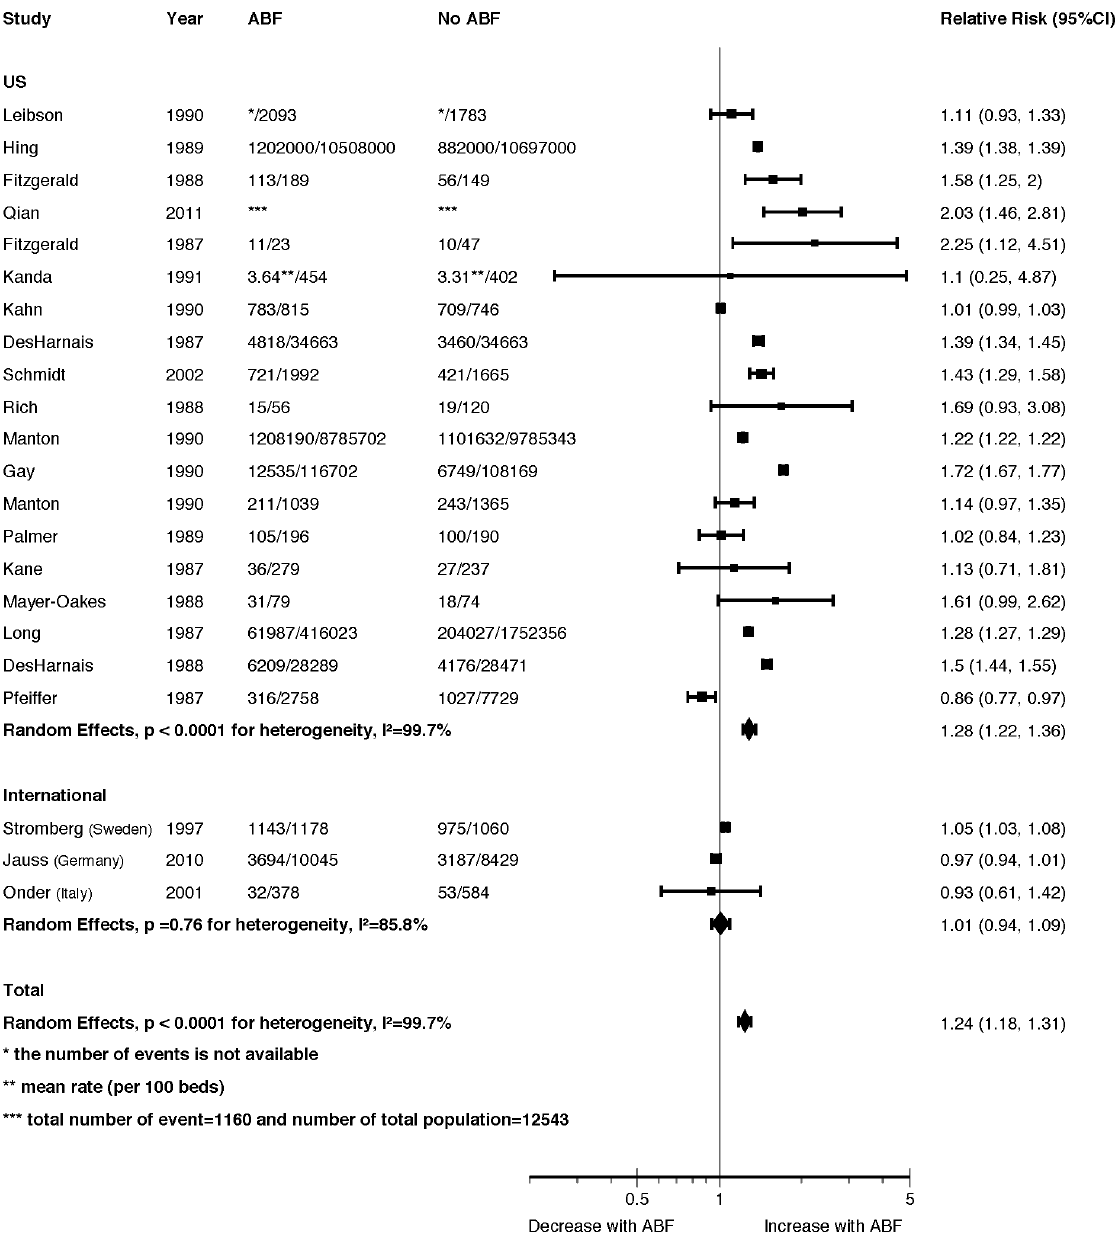
Figure 4. Discharge Destination Forest Plot.